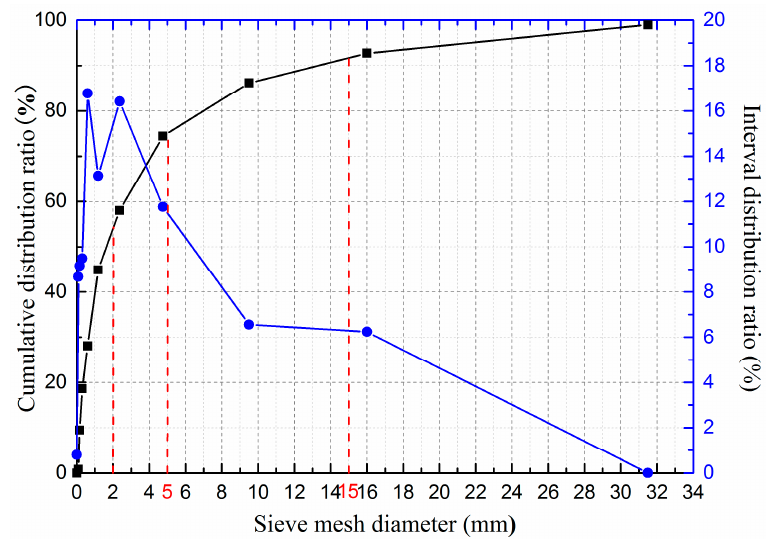
Figure 4. Cumulative and interval distribution curves of loose coal sample particle sizes.